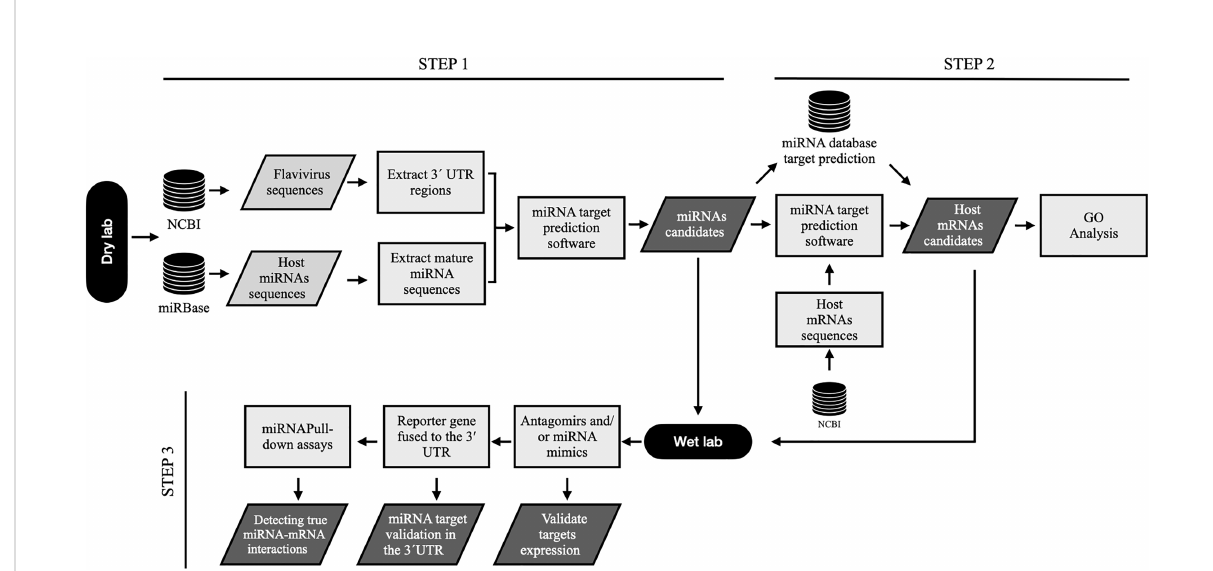
FIGURE 2 . Work fl ow to predict microRNA targets within genomic 3´UTR sequences of fl avivirus and their relevance to biological processes. Step 1, fl avivirus genome sequences and host miRNA are selected from NCBI and miRBase databases, respectively. Then, it is necessary to extract the full-length fl avivirus 3 ’ UTR sequences as well as the host microRNA sequences to predict all potential miRNA targets using algorithms predictors. Step 2, after the selection of miRNA candidates, it is necessary to determine the cellular mRNA targets to demonstrate the possible biological relevance of these microRNAs. For this, host mRNA sequences are extracted from NCBI, and target prediction is performed for the selected miRNAs. Similarly, mRNA targets can be found using databases and previously reported studies. All mRNA candidates can be used for GO analysis to determine the biological relevance of these miRNAs. Step 3, fi nally, miRNA candidates and targets are validated in the laboratory. In vitro validations can be performed using functional analysis such as transfection of inhibitors (antagomirs) or miRNA mimics, followed by target mRNA expression (qPCR or RNAseq) and protein expression (Western blotting or ELISA). Reporter gene assays, including luciferase and GFP assays, are excellent tools to demonstrate miRNA-3´UTR interactions. Biotinylated miRNA are useful probes for the identi fi cation of miRNA: mRNA interactions. For this, miRNA can be marked with biotin and transfected into the cells; then, the miRNA is sequestered and recovered (pull-down) with all possible RNA and protein interactions. The 3´ UTR can be detected in the pull-down assays using qPCR (CLIP-qPCR) o RNAseq